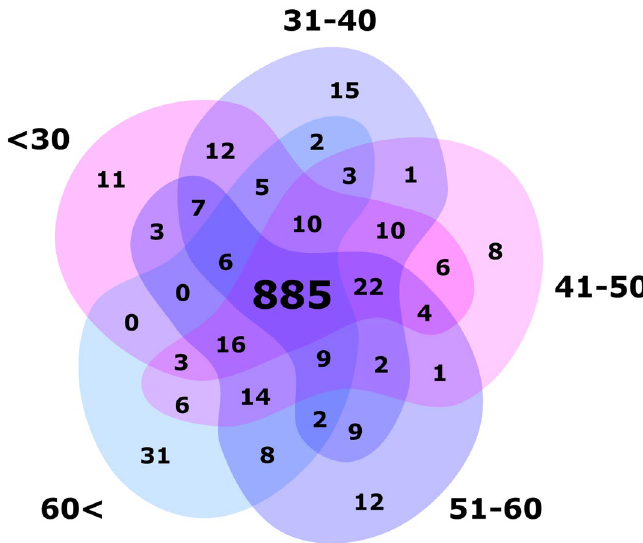
Figure 4. Top 1000 splice variants notably overlap between the studied five age